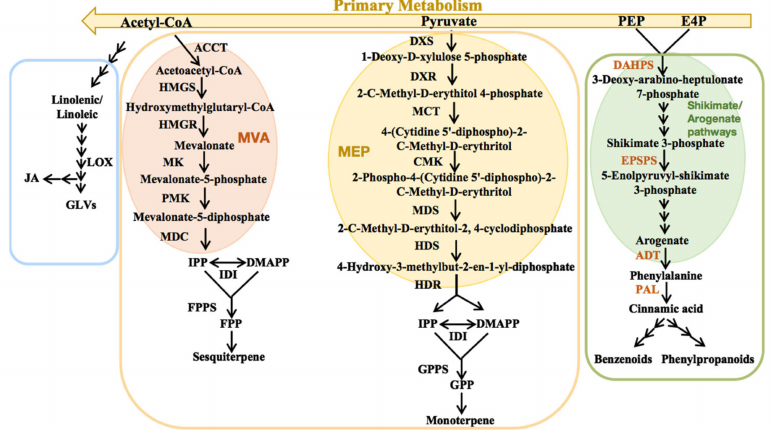
Figure 1. Overview of the main volatile organic compounds’ biosynthetic pathways: terpenoids (pink), phenylpropanoids/benzenoids (blue), and fatty acid derivatives (yellow).In this study, the components of floral scents and the expression levels of floral scent biosynthesis-related genes were identified in A. ‘Mystral’ (with strong fragrance) and A. ‘Alabama’ (with no fragrance). In addition, the floral scent biosynthesis characteristics were further explored in the F1 hybrids of A. ‘Mystral’ and A. ‘Alabama’, including the presence or absence of floral scent, the types and contents of VOCs, and the expression patterns of VOC synthesis-related genes. In this study, the hybrid progenies of Anthurium andraeanum with aroma and Anthurium andraeanum without aroma were established and the inheritance of aroma was preliminarily explored, providing a theoretical basis for the inheritance of floral scent in A. andraeanum and laying a foundation for the creation of new A. andraeanum varieties with